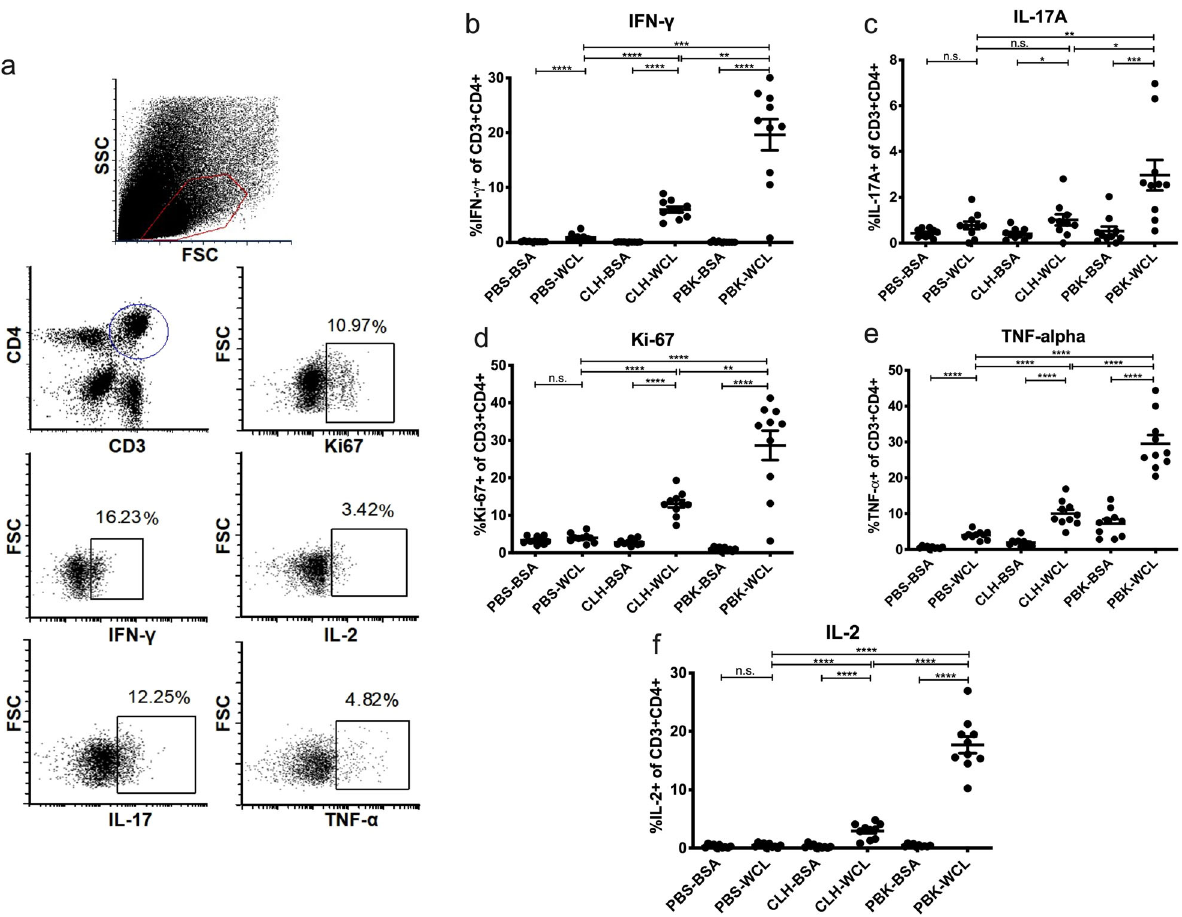
Fig. 4 CLH001 and PBK001 vaccines generate antigen speci fi c CD4 + T cells in the lung following intranasal immunization. At day 21 post vaccination, lungs of C57BL/6 mice receiving PBS, CLH001, or PBK001 were collected and disrupted cells were co-cultured with BSA (mock) or BMDC pulsed with 1 μ g of heat-killed Bpm K96243 WCL. The cultured cells were harvested after incubation at 37 °C and 5% CO 2 for 72 h, with addition of a Golgi protein transport inhibitor during the last 4 h of incubation. The markers were used to identify CD3 and CD4 T-cell populations and intracellular cytokines. a Representative gating strategy used to identify live cells with forward and side scatter properties of lymphocytes followed by selection of cells expressing the T lymphocyte markers CD3 and CD4. Intracellular cytokines including IFN- γ , TNF- α , IL-2, and IL-17 were further detected, along with the Ki-67 proliferation marker, following fi xation and permeabilization of cells. Expression of intracellular cytokines IFN- γ ( b ), IL-17A ( c ), proliferation marker Ki-67 ( d ), TNF- α ( e ), and IL-2 ( f ) by CD3 + CD4 + T cells was determined in lungs of vaccinated and non-vaccinated mice. Data are represented as mean ± SEM from 10 mice/group. Signi fi cant values were analyzed using t -test or Mann – Whitney test (* p < 0.05, ** p < 0.01, *** p < 0.001, **** p < 0.0001, n.s. = not signi fi